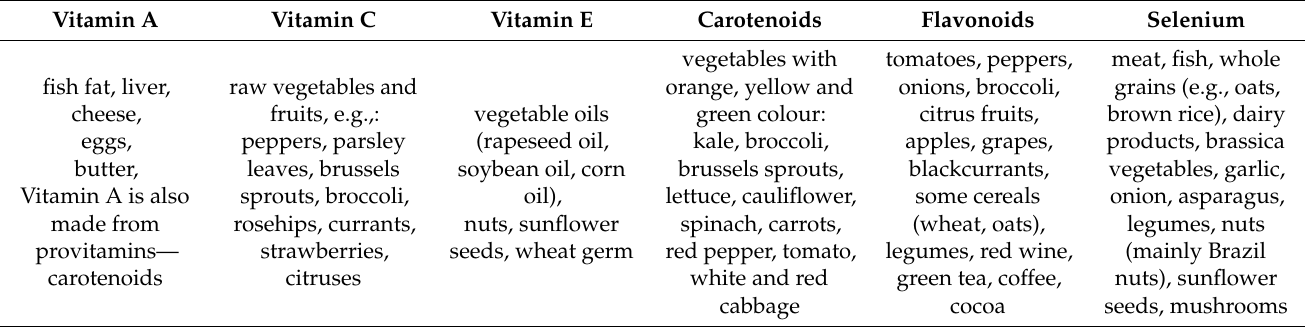
Table 1. Sources of selected antioxidants